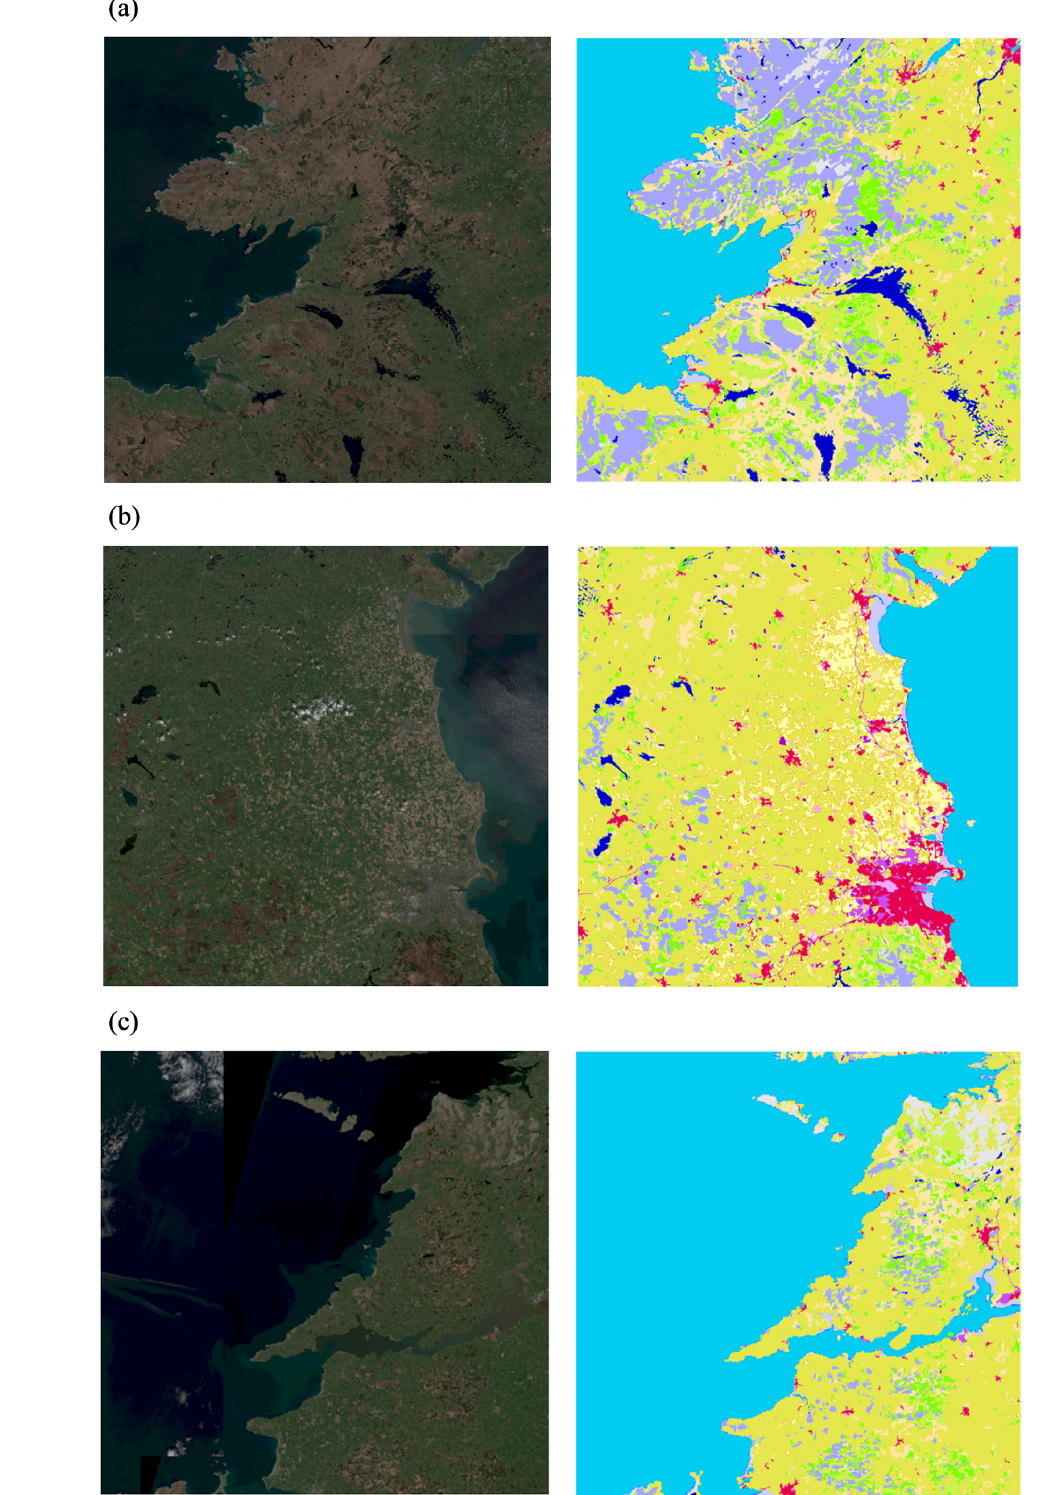
Figure 3. Sentinel-2 tiles and corresponding CORINE tiles used to train the Primary and Secondary UWPs. (a) Donegal in the North-West of Ireland (b) Dublin City and its surrounds on the East Coast of Ireland. (c) County Clare on the West Coast of Ireland. The satellite images were produced from ESA remote sensing